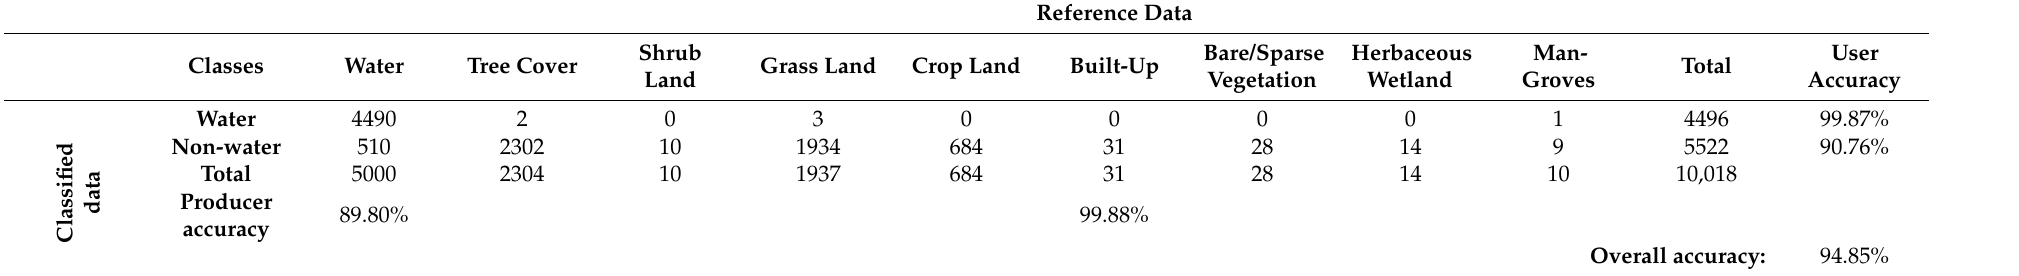
Table 8. Accuracy assessment results for NDCHRWI Hue with slope, urban, and snow